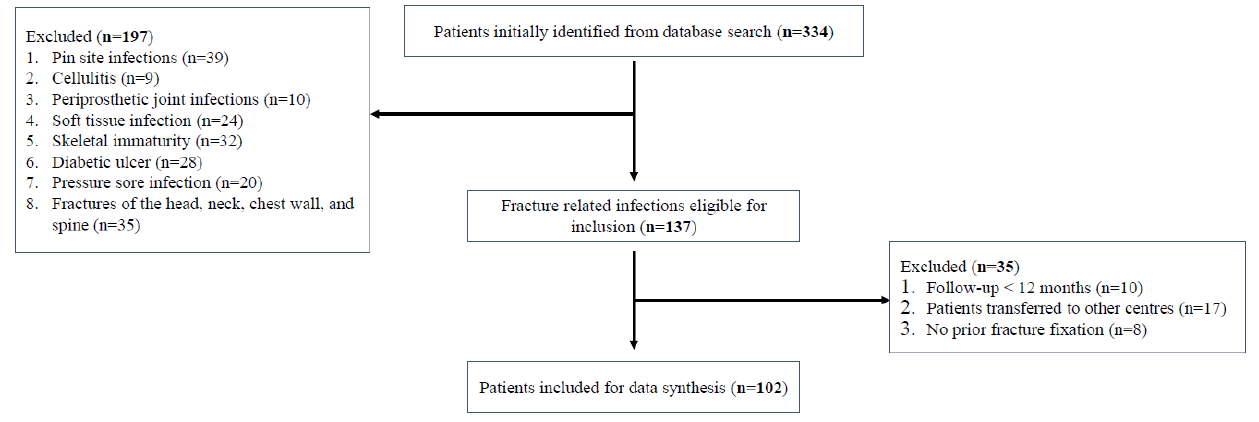
Figure 2. Flow diagram showing number of patients at each stage of the study.